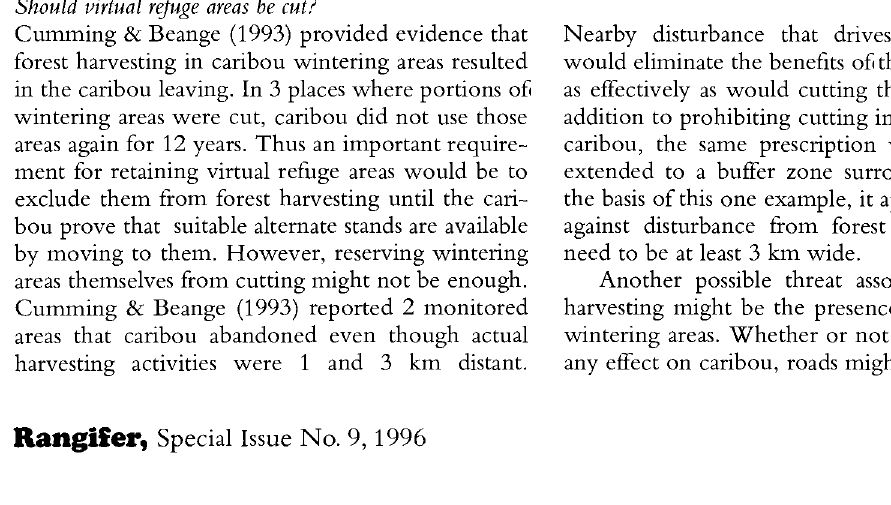
Fig. 1. Management at the landscape level may not ensu re survival of caribou with partitioned habitat. If caribou were currently wintering in Area 1, the distant cutting would do them no harm. If they were using Area 2, adacent cutting might cause disturbance, reduce moose densities, incline wol ves to switch from moose, and lead individual wolves along ecotones directly to the caribou. If caribou were using Area 3, cutting would proba bly cause caribou to leave and that would